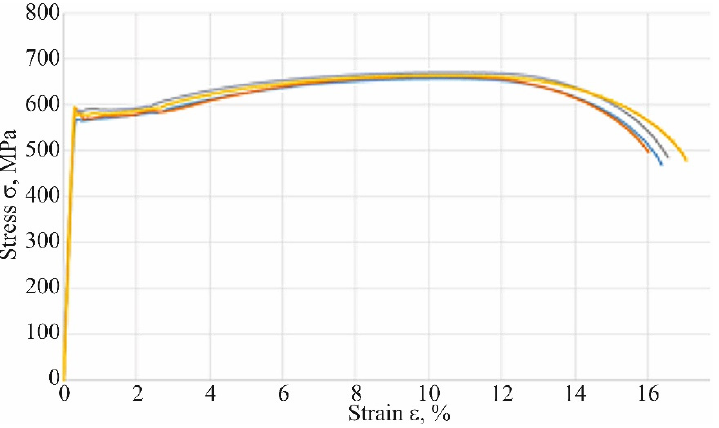
Figure 23. Experimental stress–strain diagrams.